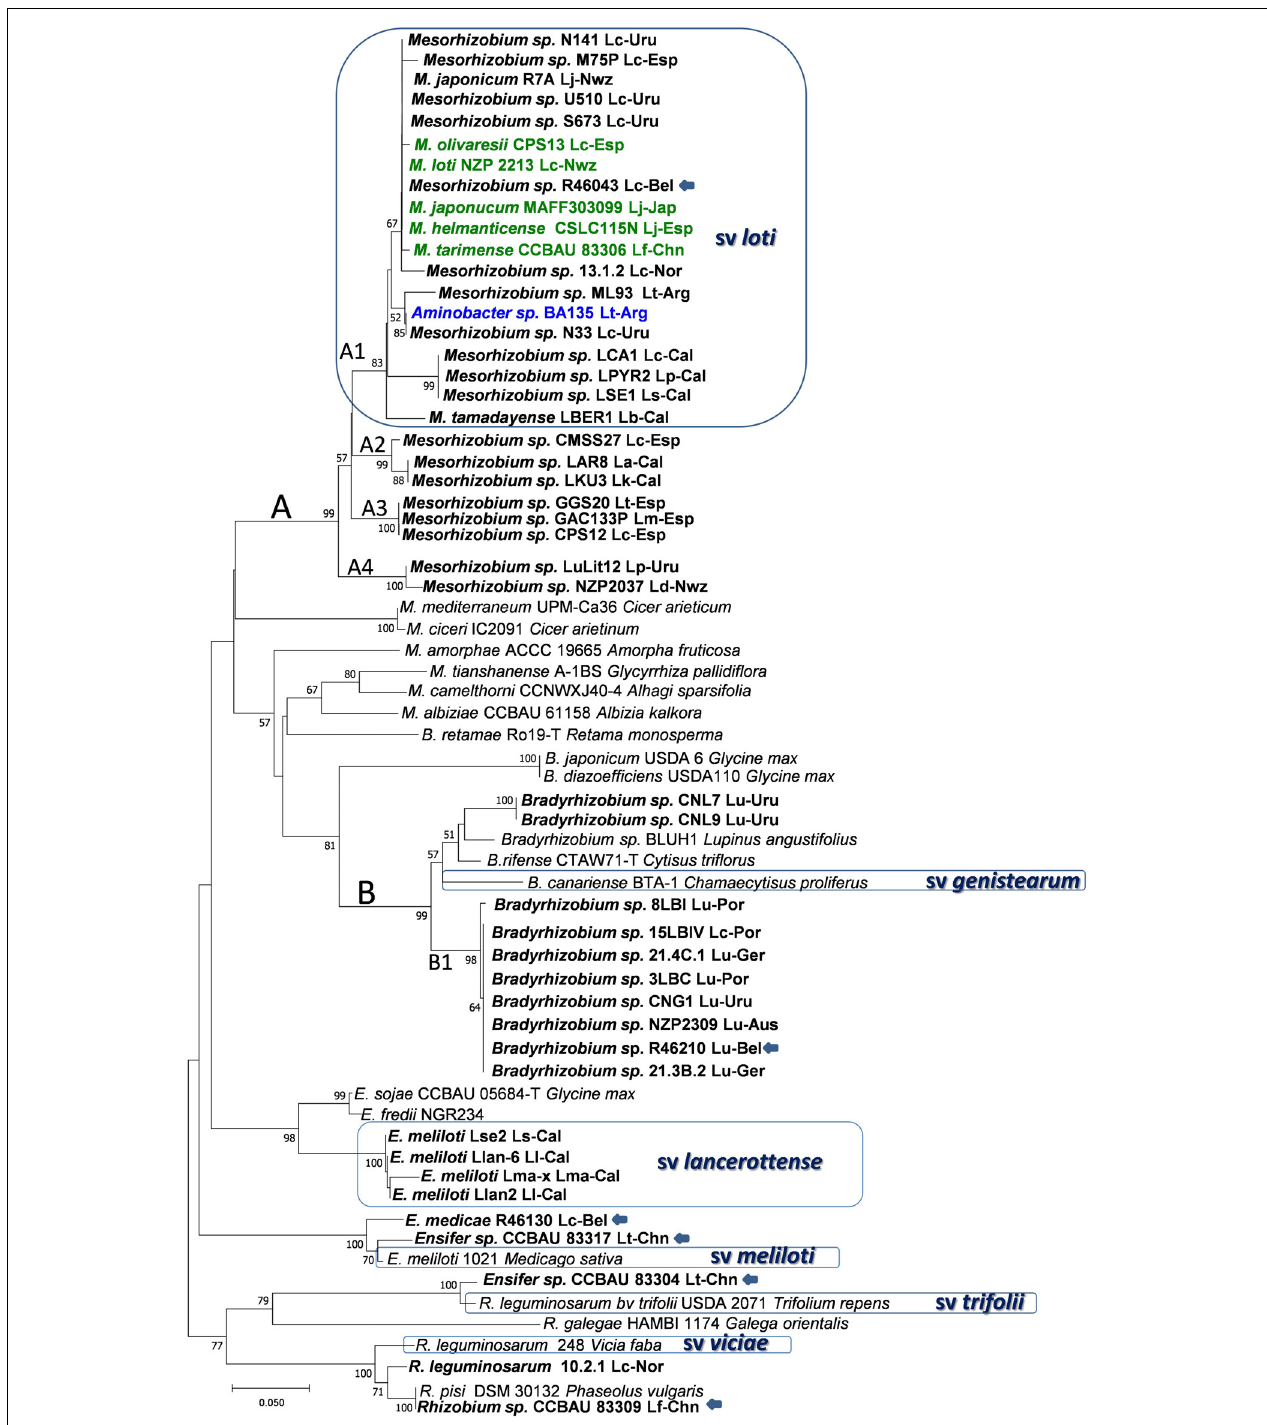
FIGURE 2 | Phylogenetic tree of nodC gene sequences. Bold names correspond to Lotus rhizobia, with original Lotus species and country of isolation indicated. In bold green are rhizobial species which have Lotus symbionts as type strains. Previously defined symbiovars are indicated. Strains with unconfirmed symbiotic phenotypes in Lotus are indicated with an arrow. Analyses were conducted with MEGA using Neighbor Joining Maximum Likelihood (NJML), for a total of 203 positions. Abbreviations and accesions numbers are as in Figure 1 .